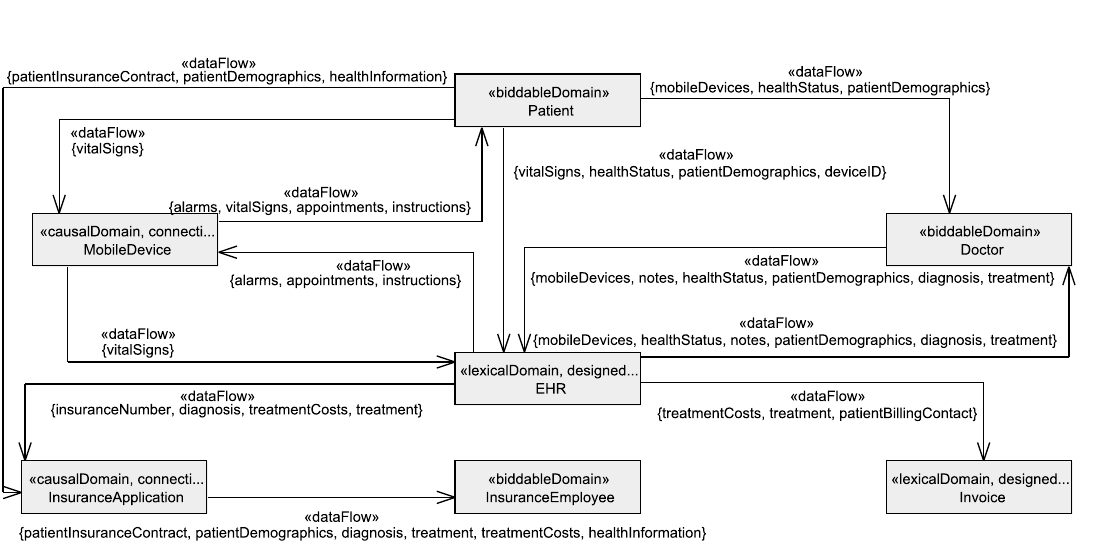
Figure 13. Excerpt of the Stakeholder Data Flow Graph for the stakeholder